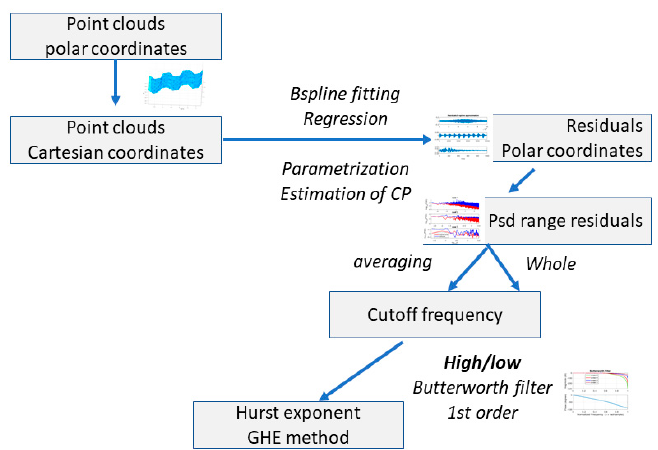
Figure 11. Summary of the methodology to extract the Hurst parameter from the range residuals of a B-spline approximation from a TLS point cloud.